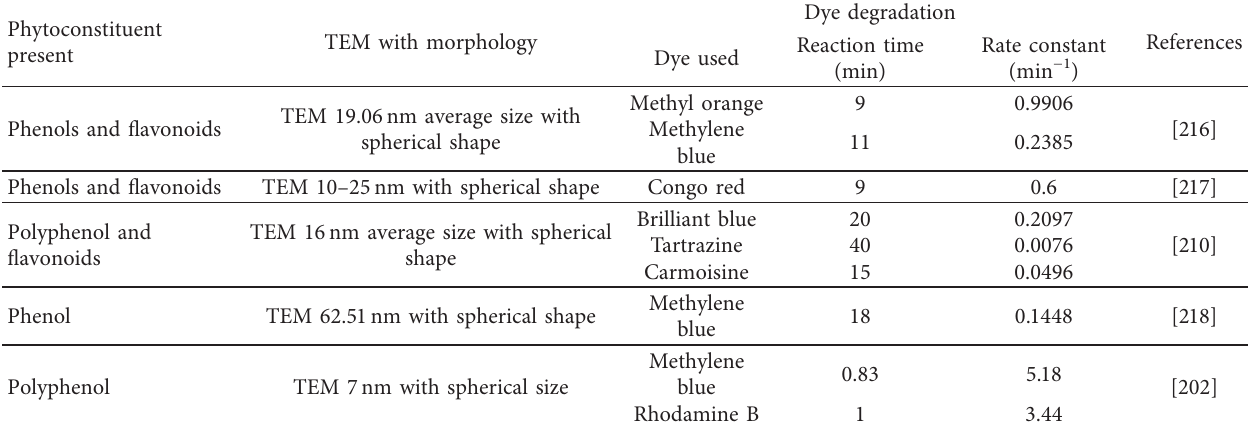
Table 9: Morphology of green synthesized Ag NPs and their dye degradation